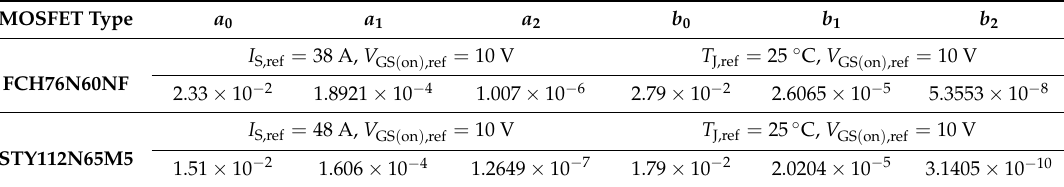
Table A2. Coefficients ( a 0 , a 1 , a 2 and b 0 , b 1 , b 2 ) required to evaluate (20) and (21), i.e., the second order approximations of the dependency of the drain to source on-resistance R DS ( on ) on the junction temperature T J and on the switch current I S for the used